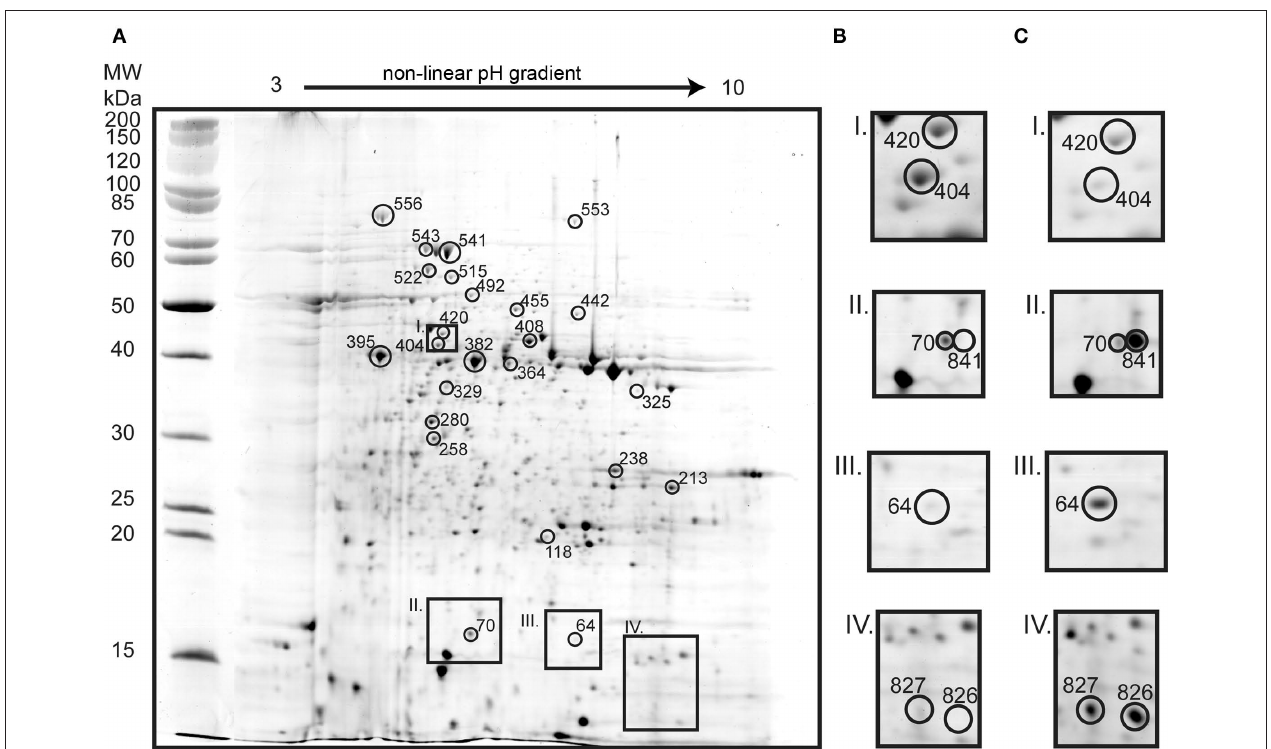
(I); single-stranded DNA-binding protein (70) 3.1-fold up-regulated in sessile cells and sulfur oxidation protein SoxY (841) unique in gels from planktonic cells (II); twin-arginine translocation protein TatA (64) was up-regulated 7.9-fold in planktonic cells (III); and hypothetical protein ACA_0867 (spots 827 and 826) uniquely found in planktonic cells